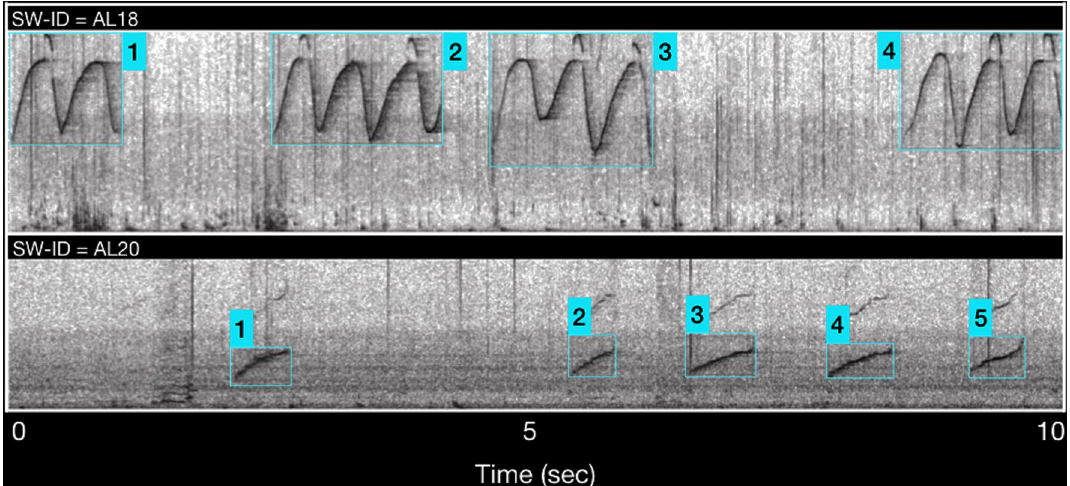
Figure 8. Example of SW-IDs. The number represents the stereotyped contours (referred as SW in the text) of the